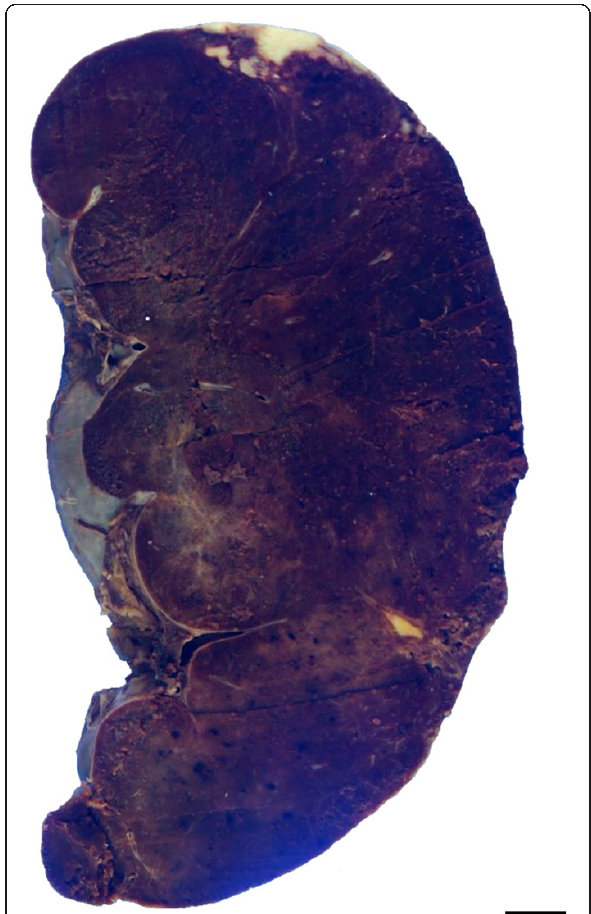
Figure 2 Gross examination of splenic HS from the resected specimen. On gross examination of the splenomegaly, the cut surface showed multiple foci of peripheral anemic infarction, but not any mass or nodular lesions, which predominantly looked dark-red in colour associated with congestive red pulp and depleted white pulp. Bar = 10